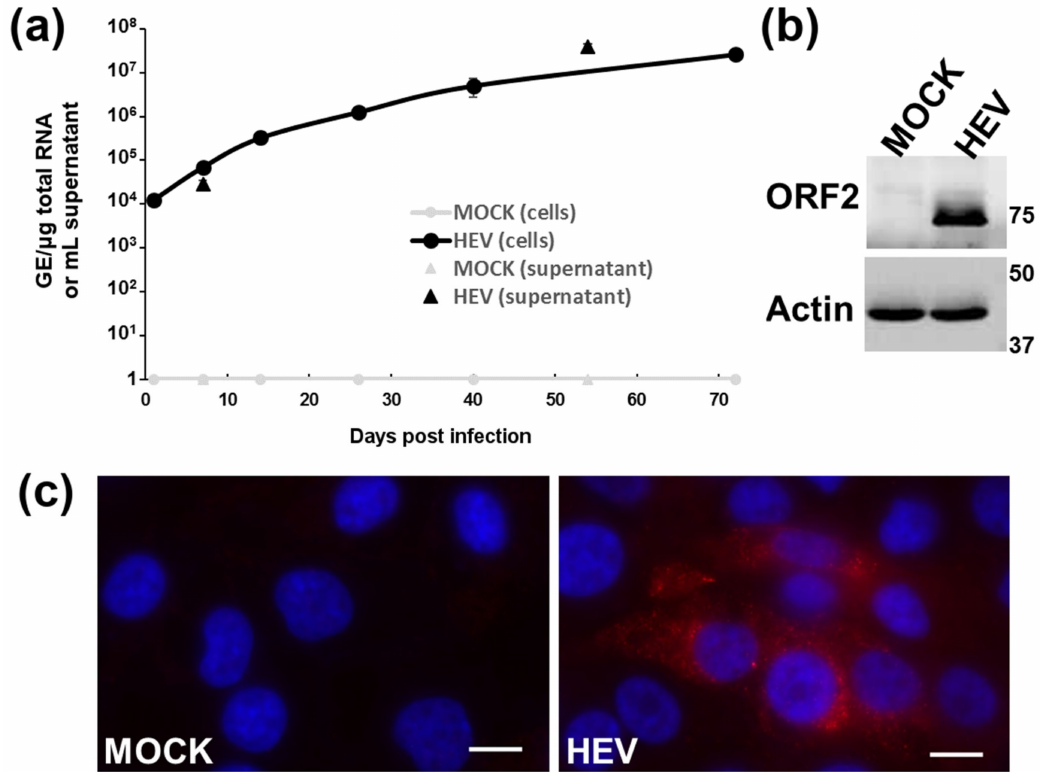
Figure 2. Detection of Hepatitis E virus (HEV) replication ( a ) and open reading frame (ORF)2 expression by immunoblotting ( b ) and immunofluorescence ( c ) within HEV-infected HepaRG cells. ( a ) Differentiated HepaRG cells were infected with the HEV-3f strain (passage 7) at a multiplicity of infection (MOI) of 10. The HEV genome present in cells and in the supernatants was quantified using RT-qPCR at different days post-infection. Results presented are the mean of triplicate samples ( ± standard deviations) (3 parallel infections). ( b ) Differentiated HepaRG were infected with HEV-3f (passage 6) at a MOI of 5 and cell lysates harvested 128 days post-infection. ( c ) Differentiated HepaRG cells were infected with HEV-3f (passage 7) at a MOI 50 for 37 days. Scale bars: 10 µ